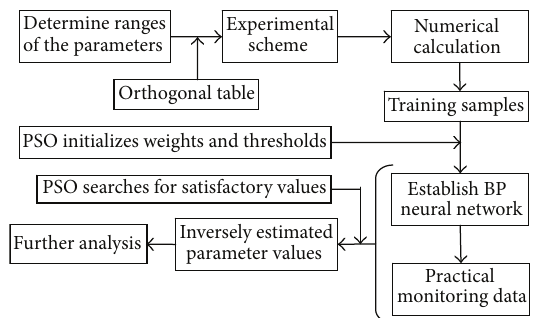
Figure 5: Back analysis flow chart based on BP neural network opti- mized by